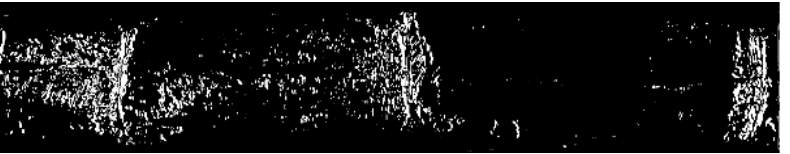
Figure 11. Binarization results of the gradient image.